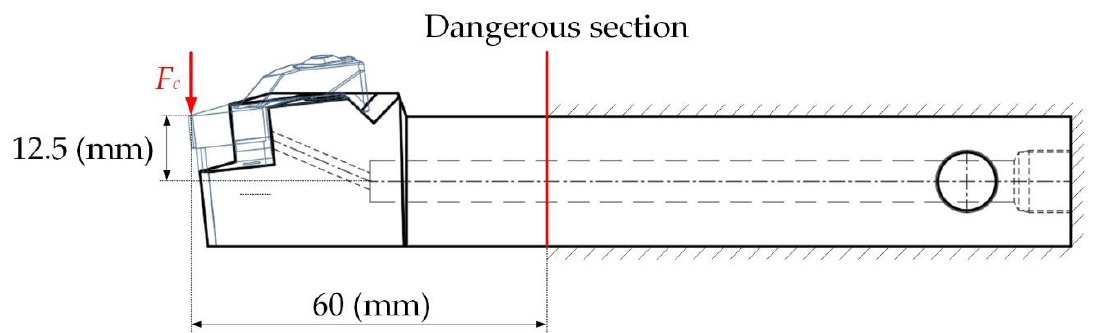
Figure 6. Cutting force acting on the tool.